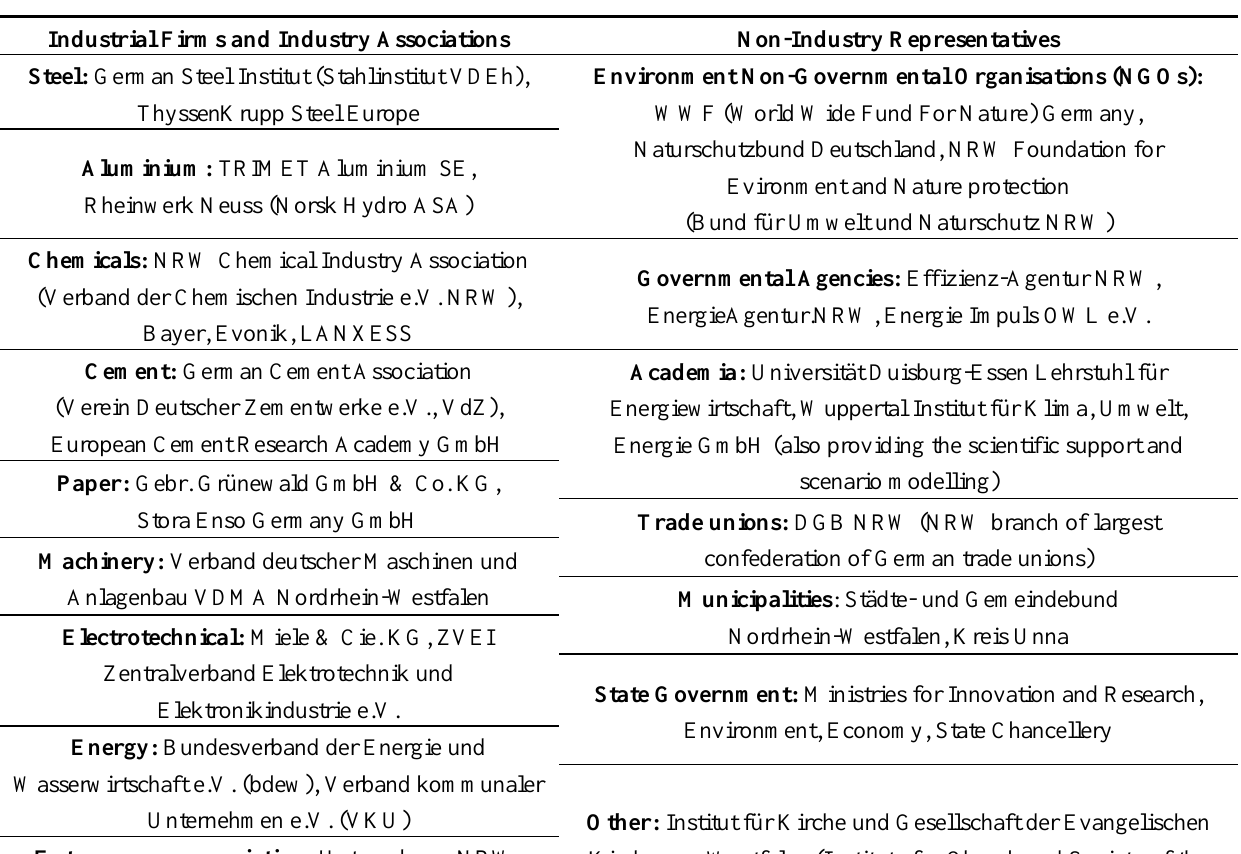
Table 2. List of affiliations of stakeholder representatives who participated in the “Industry” working group of the CPL